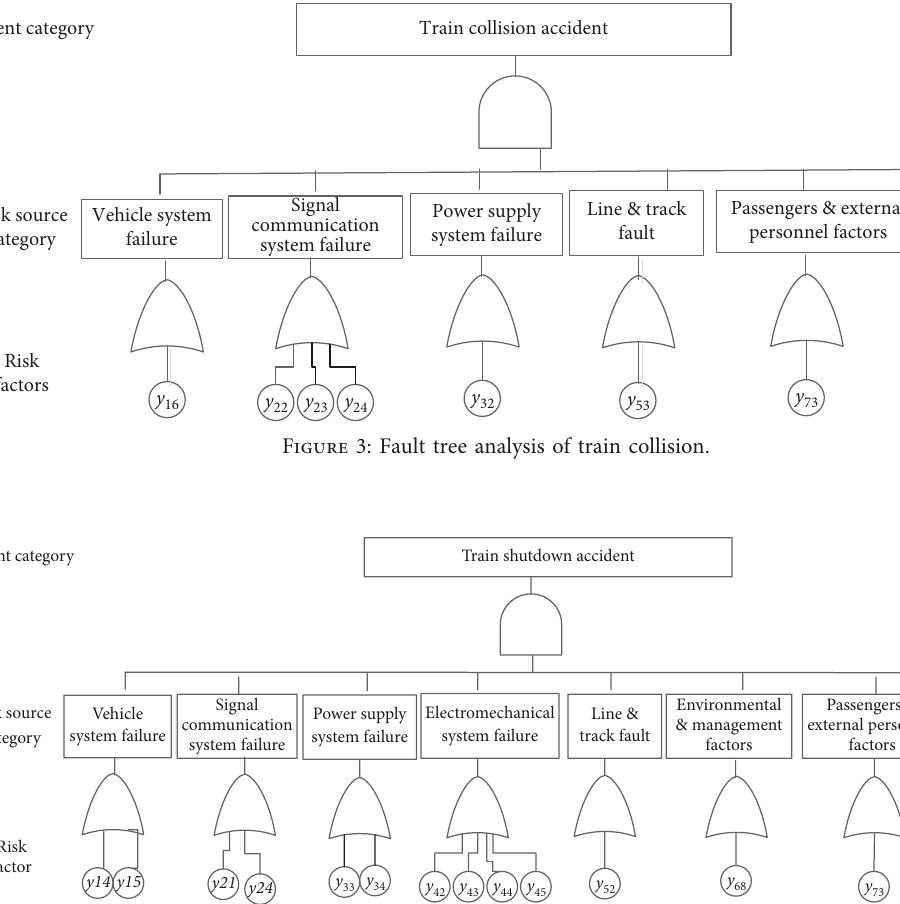
Figure 4: Fault tree analysis of train